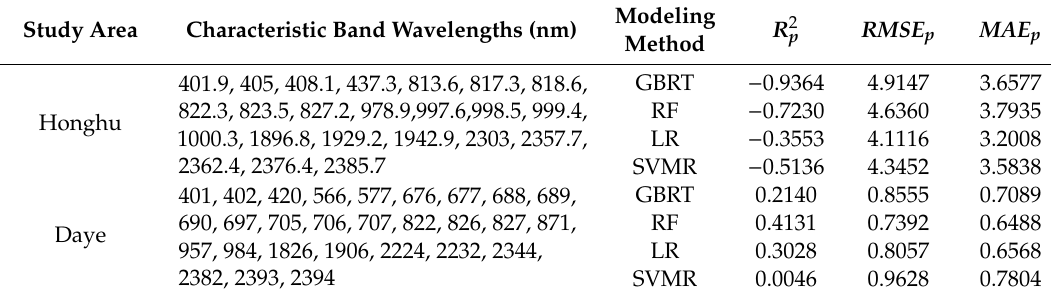
Table 2. Accuracy validation of the di ff erent models.